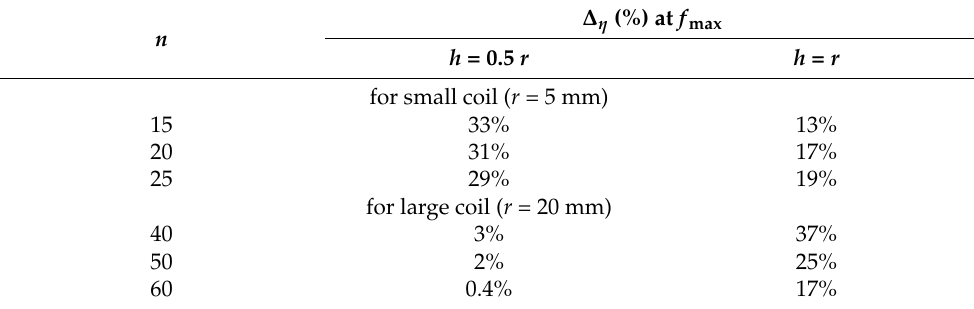
Table 10. The difference between the efficiency of the system in the periodic model and the aperiodic model with the use of circular